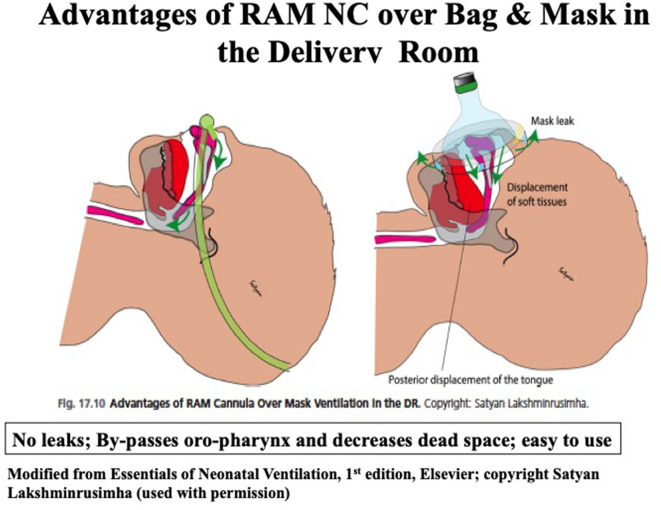
Application of RAM NC in the NICU.